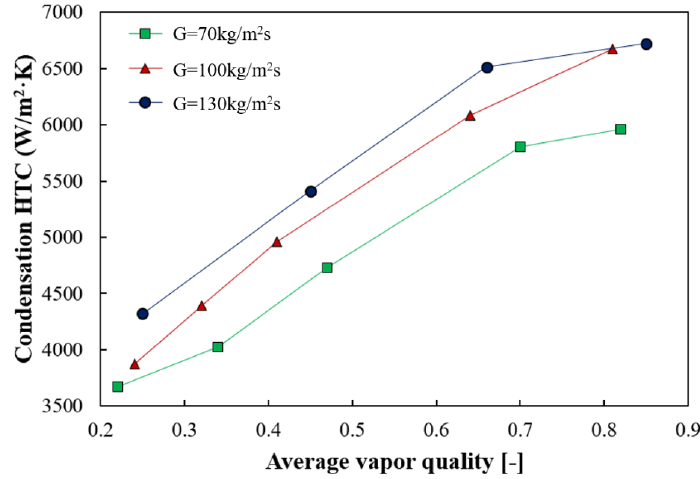
Figure 6. Variation of condensation HTC according to mass flux at various vapor quality condition. 𝜌 l and 𝜌 g are liquid and gas density, respectively. In Equation (17), 𝑅𝑒̇ eq denotes the equivalent Reynolds number and 𝜇 l is the viscosity of liquid.